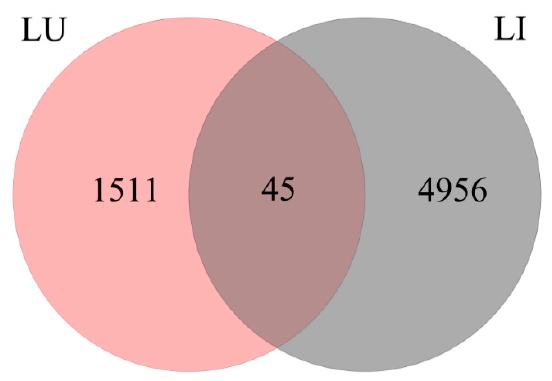
Figure 4. Venn diagram of differentially expressed genes (DEGs) identified through pairwise comparison between group LU and group LI.